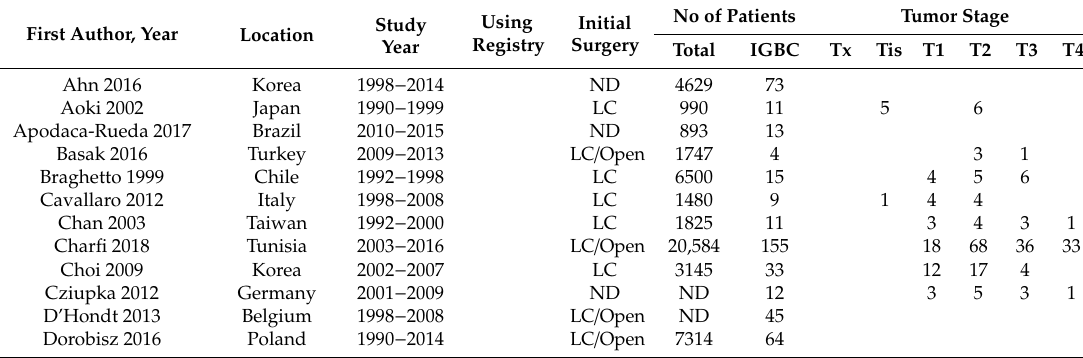
Figure 1. Flow chart of the study search and selection methods. Table 1. Main characteristics of the eligible studies.